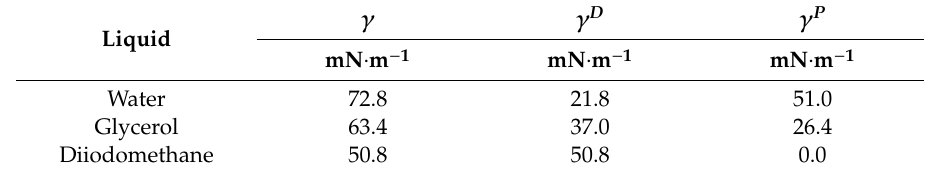
Table 2. Dispersive γ D and polar γ P components of water, glycerol, and diiodomethane [38,39].